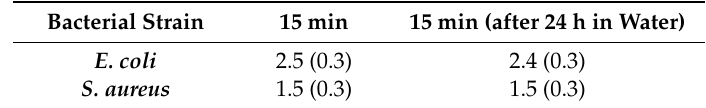
Table 2. Thermal ME (ME T ) values 1 for GLASS-PEI-TRI